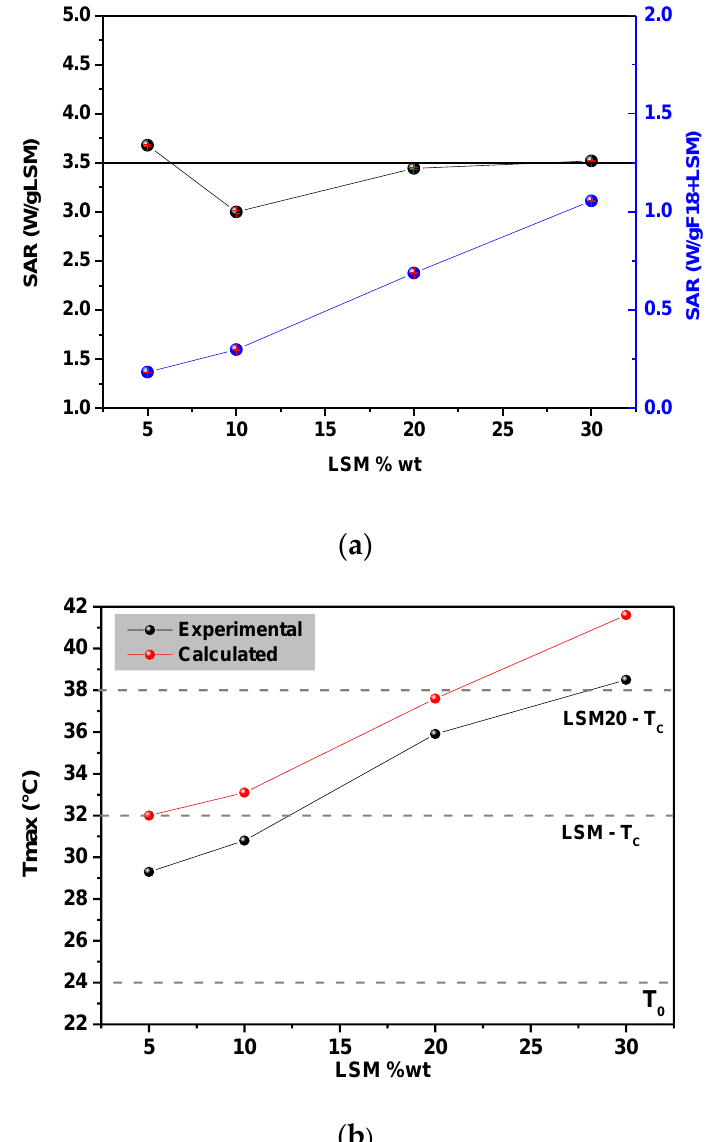
Figure 14. ( a ) SAR value obtained from experimental data using Equation (4) normalized by the mass of LSM in the composite. The inset is SAR value considering the mass of the composite components F18 + LSM. ( b ) Comparison between T max obtained by experimental data and T max calculated by Equation (3).